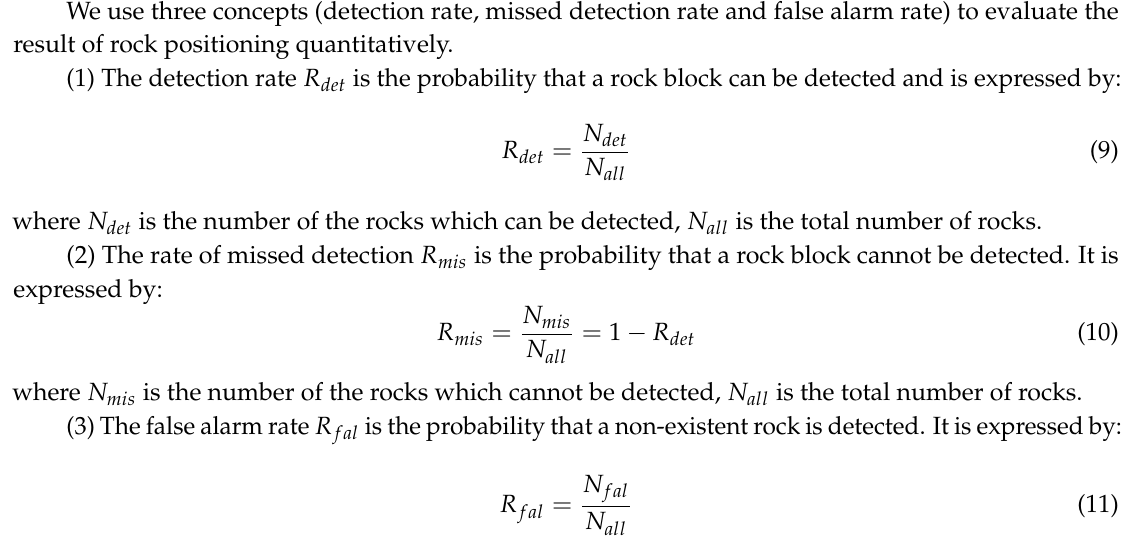
Figure 9. The comparison of rock positioning.